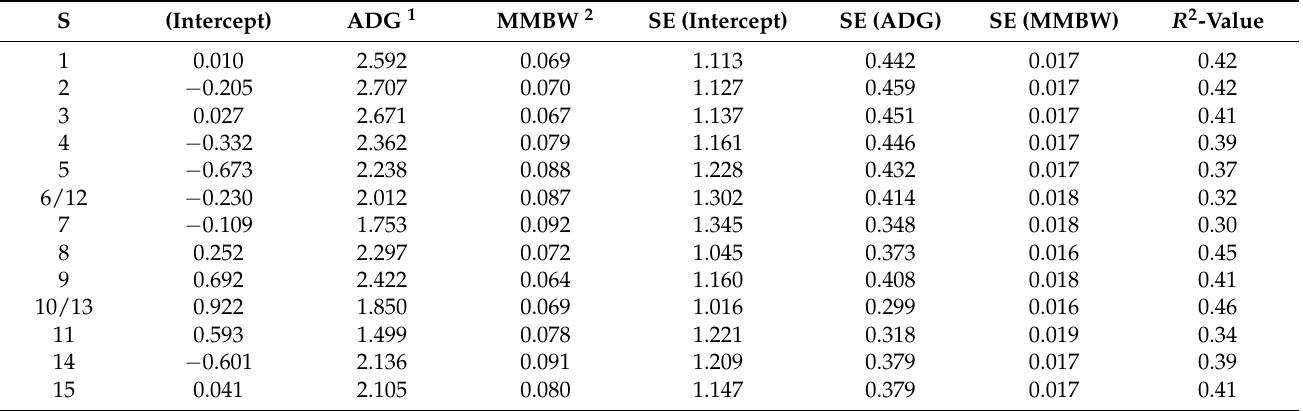
Table 6. Regression coefficients, their standard errors (SE), and the R 2 value for different